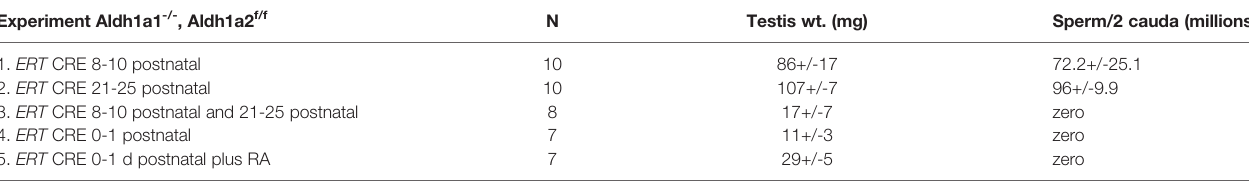
TABLE 2 | The Aldh1a1 -/- , Aldh1a2 f/f mice were crossed with the ERT Cre. Experiment Aldh1a1 -/- , Aldh1a2 f/f N Testis wt.